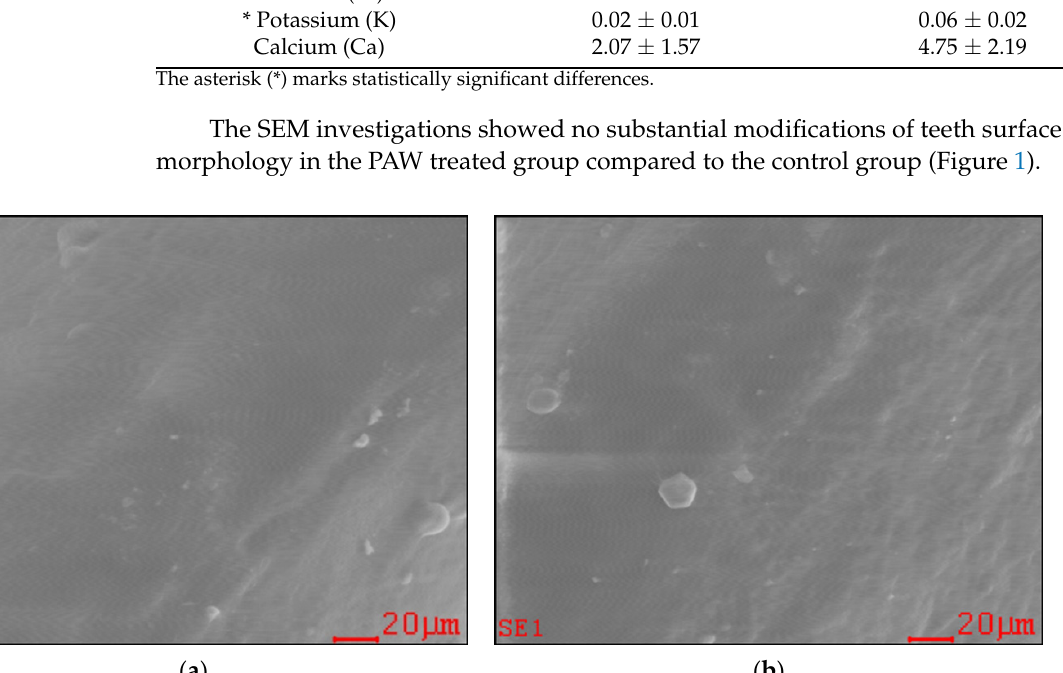
( b ) Figure 2. AFM topography of teeth surface: ( a ) mouse from the control group; ( b ) mouse from the PAW treated group. 2.2. The Effects of Long-Term PAW Consumption on Vital Organs 2.2.1. Weight The weight of organs that are essential for maintaining body homeostasis (heart, spleen, liver, kidneys, brain) was measured (Table 2). The analyzed organs did not show significant differences in weight between the two groups of mice ( p > 0.05), with the ex- ception of the spleen that was smaller in the PAW group, both in terms of absolute ( p = 0.01) and relative weight ( p = 0.005). Table 2. The absolute and relative weight of the essential organs. ORGAN